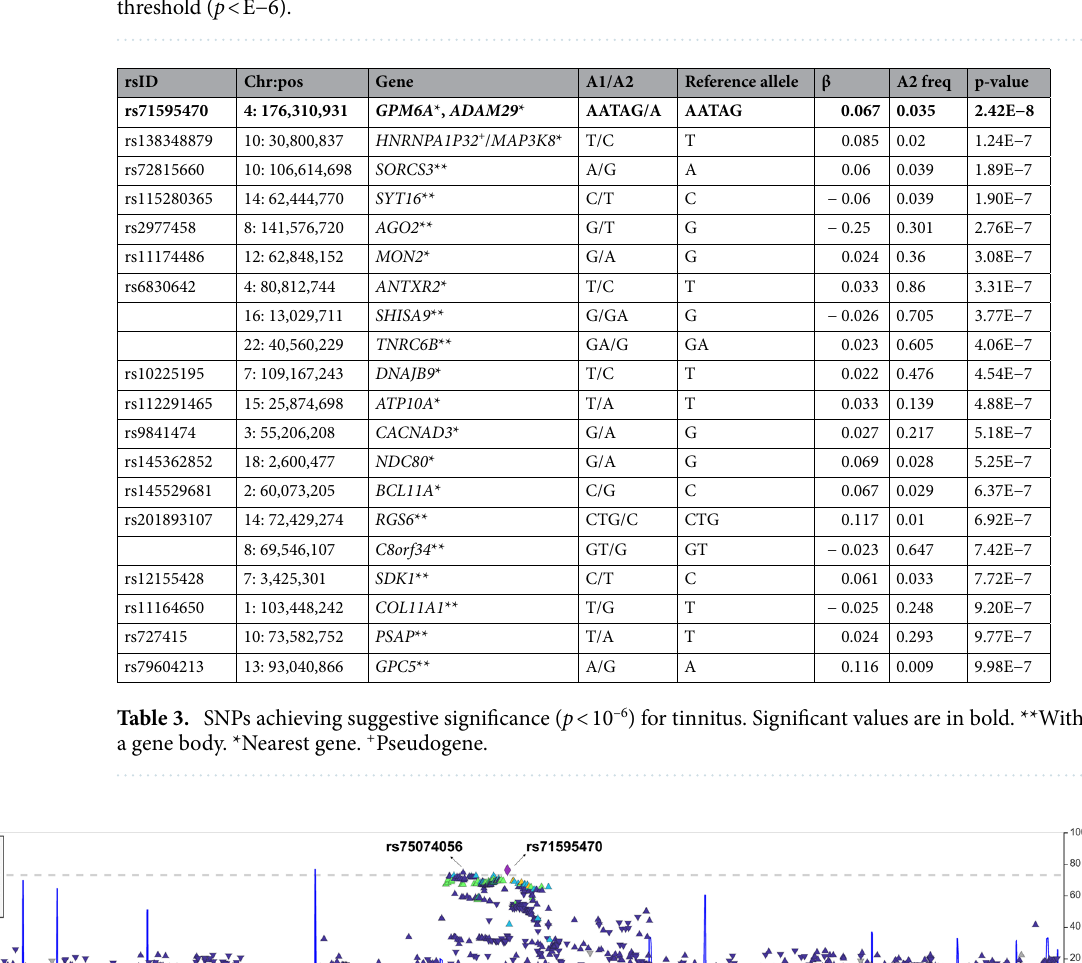
Figure 1. Manhattan plot for the genome-wide association study on tinnitus. The dashed gray line presents the genome-wide significance threshold ( p < 5E−8), and the dashed black line indicates the suggestive significance threshold ( p < E−6).